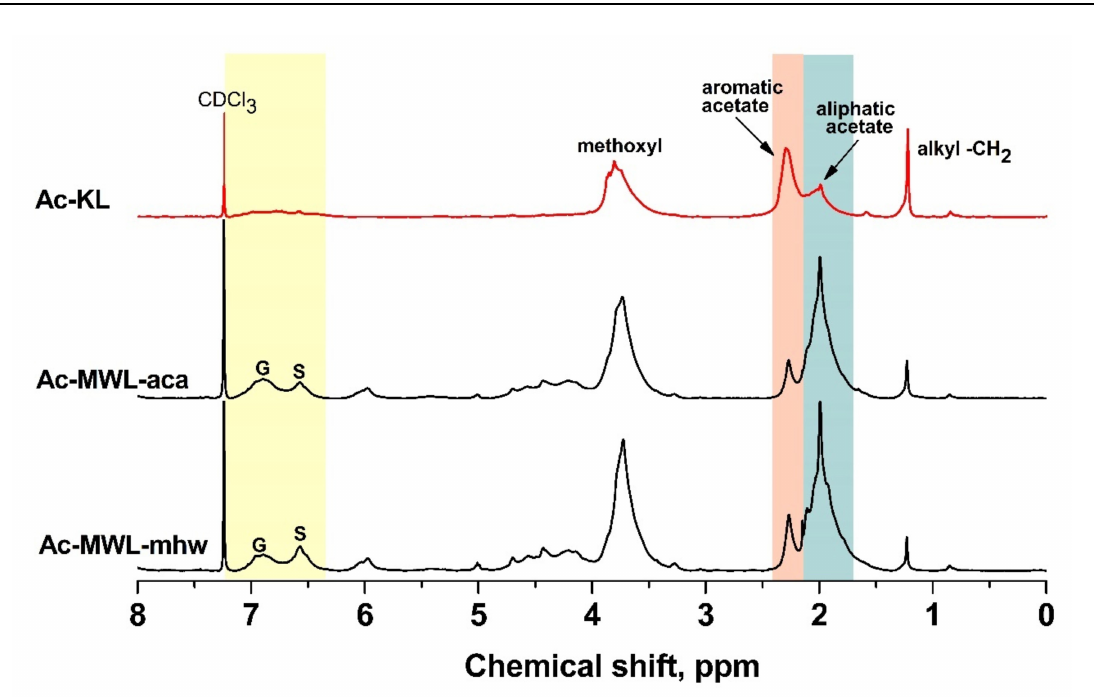
Figure 4. 1 H NMR spectra of Ac-lignins. The aromatic protons per C 9 unit for Ac-KL were 0.52 for S units and 0.37 for G units, while for Ac-MWL-mhw the aromatic protons per C 9 unit were 0.84 for S units and 0.57 for G units. Comparing the integration values of Ac-KL to Ac-MWLs, the decreased number of aromatic protons indicated a highly condensed structural motif in KL. The integration values were converted to their molar counterparts to estimate the S to